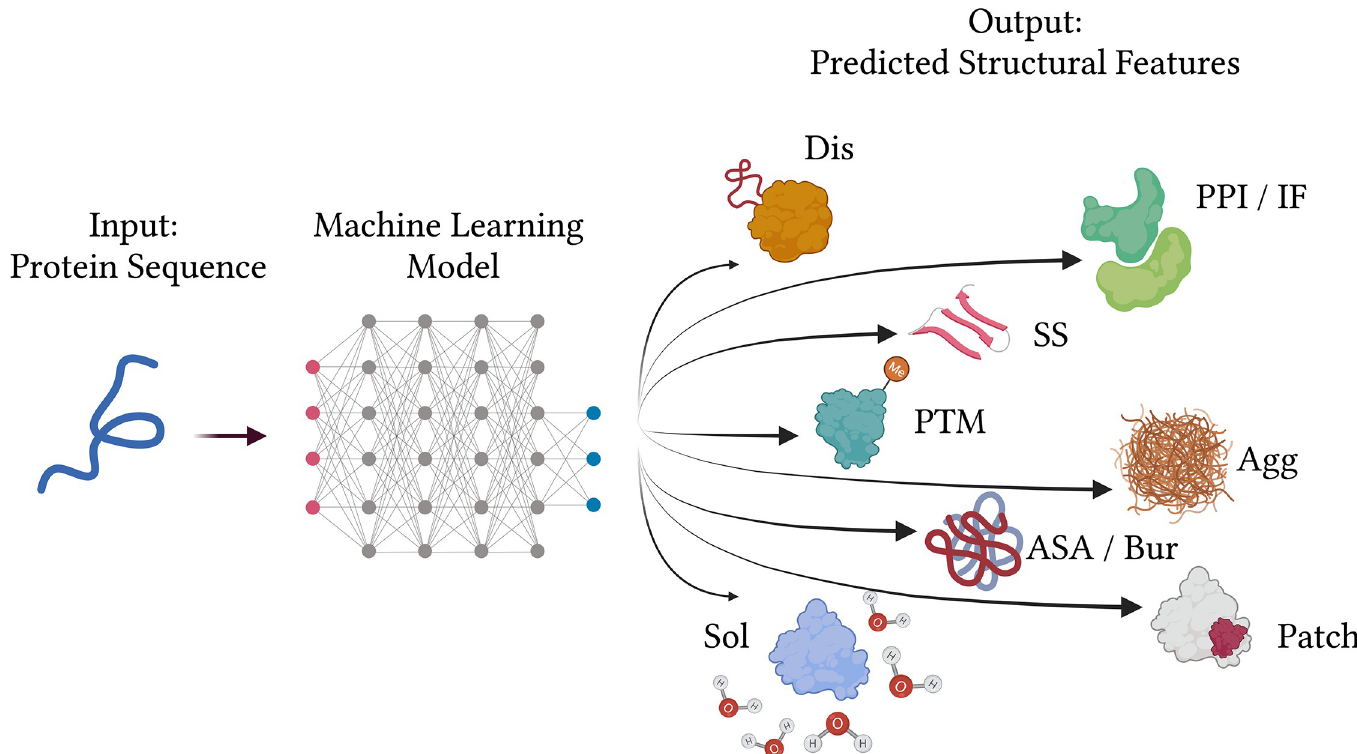
Fig 1. Sequence-based prediction of protein functional structural properties aims to fill the gap between relatively scarce functional annotations, or protein structures, and ubiquitously available sequence data. Predicting structure and function related properties such as disorder (Dis) , secondary structure (SS) , solvent accessible surface area (ASA) or buried vs. exposed residues (Bur) , posttranslational modification sites (PTM) , large hydrophobic patches (Patch) , aggregation propensity (Agg) , protein–protein interaction or other interfaces (PPI/IF) , or solubility (Sol) . Created with Biorender.com.